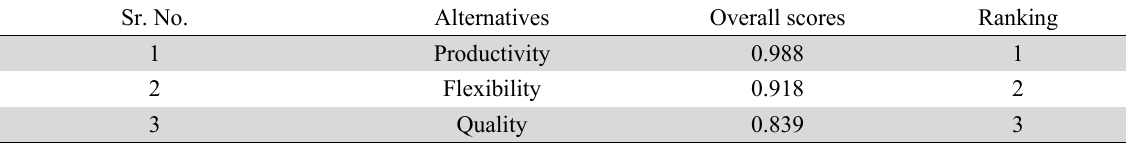
The overall scores of alternatives Sr.